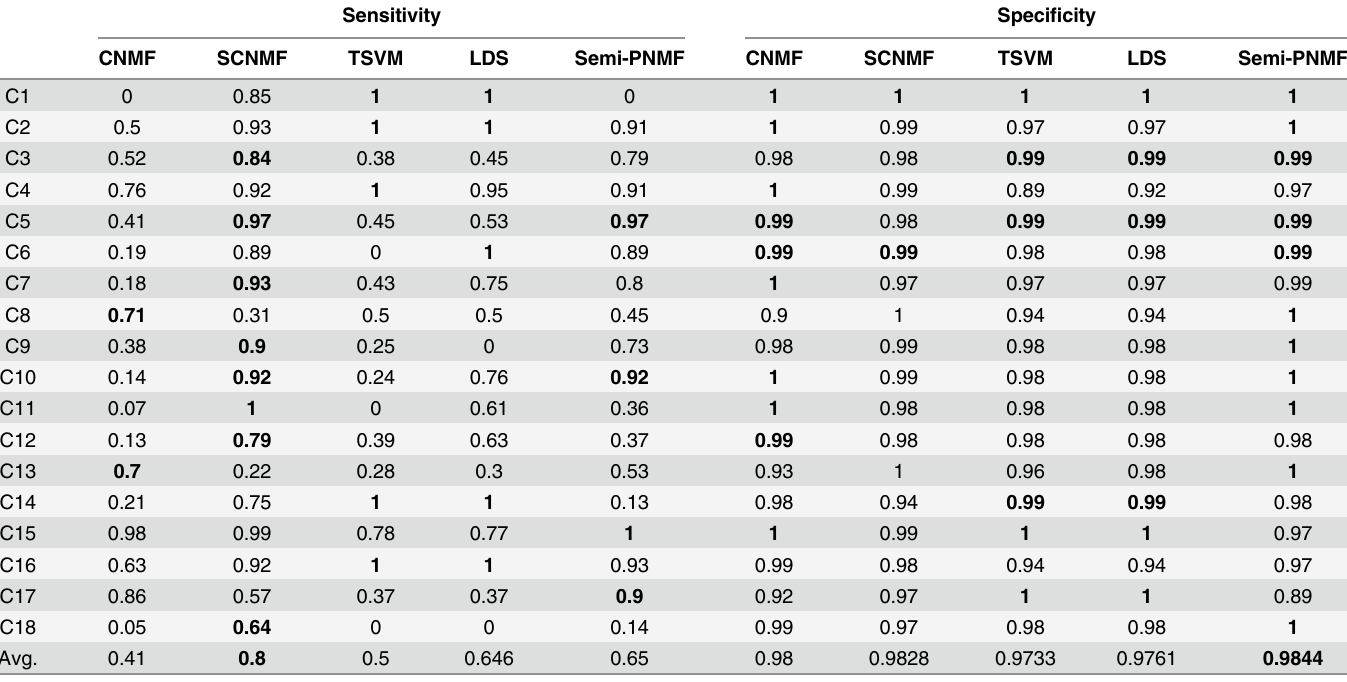
Table 4. Sensitivity and Specificity of the compared methods over 18 cancer subtypes on the Acute Leukemia